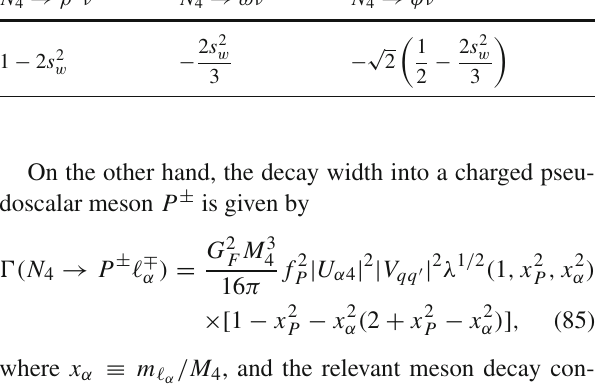
Table 2 Expressions g V entering the heavy neutrino decay widths into neutral vector mesons, Eq. (86) N 4 → ρ 0